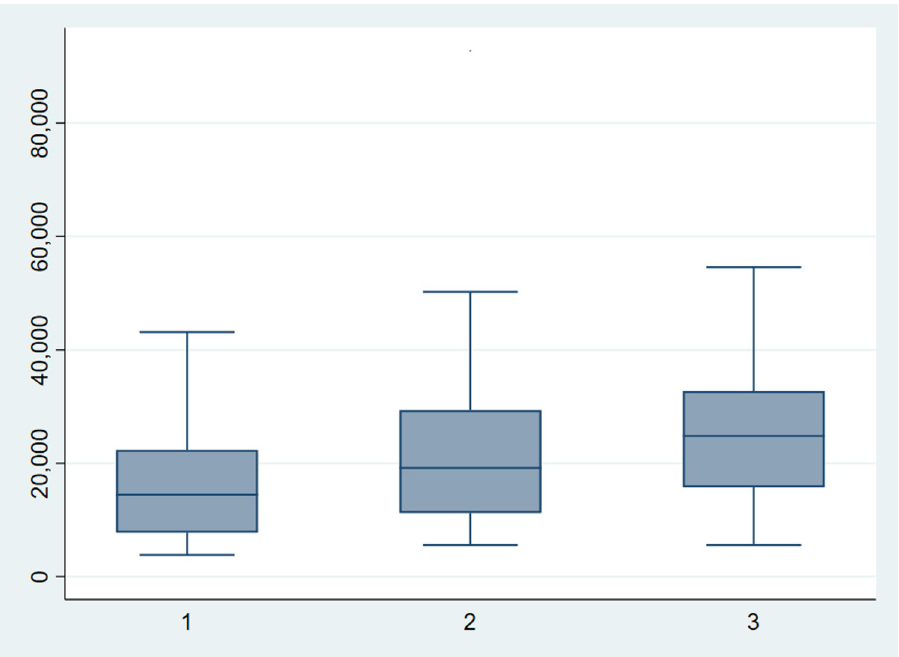
Fig 2. Box plot of adjusted hospital costs by severity grade.